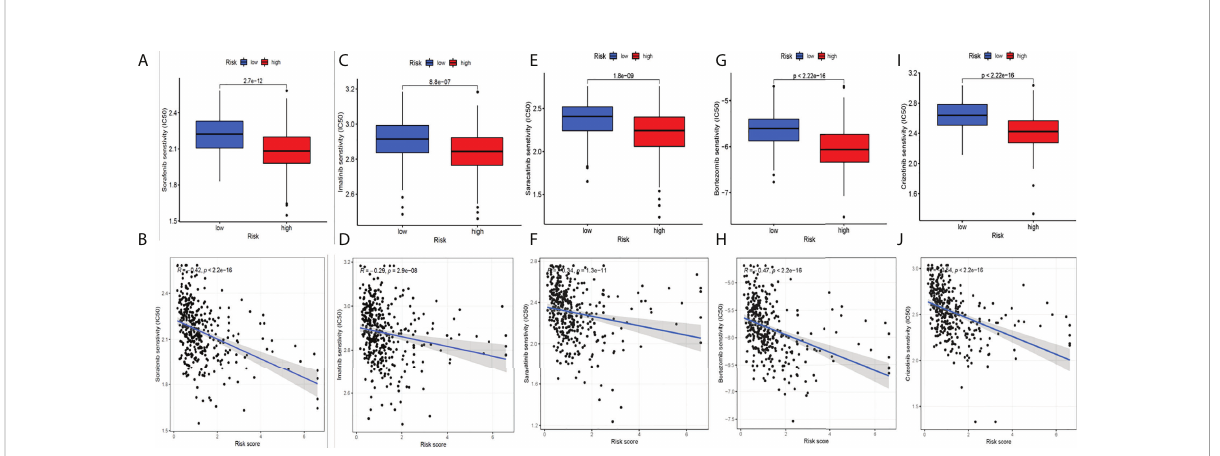
FIGURE 8 Screening potential drugs for HCC. Five drugs with great differences in drug sensitivity between two groups: sorafenib (A-B) , imatinib (C-D) , saracatinib (E-F) , bortezomib (G-H) and crizotinib (I-J)